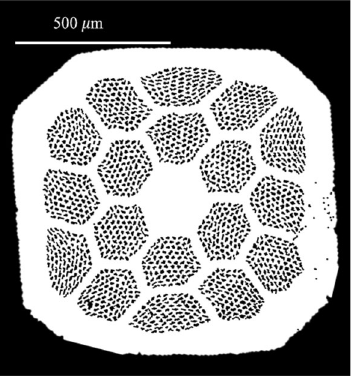
Figure 8. Cross section of